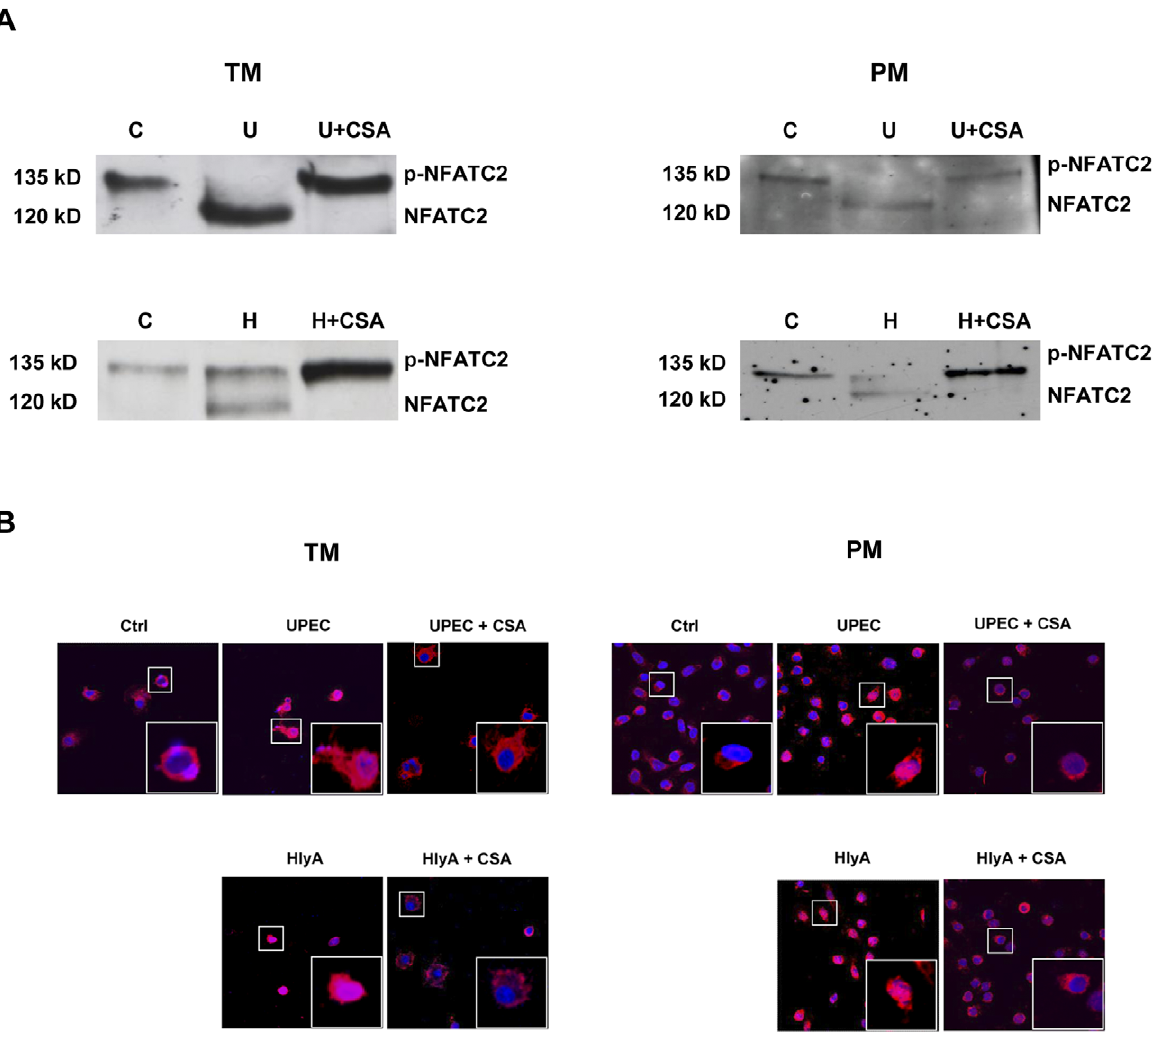
Figure 5. UPEC activates NFATC2 signaling pathway. ( A, B ) PM and TM were treated with UPEC CFT073 (MOI=20) for 1 h. ( A ) TM and PM were pretreated for 15 min with 2 m M cyclosporine A (CSA) or left unstimulated, followed by incubation with UPEC CFT073 or 40 ng/ml alpha- hemolysin (H) for 30 min, respectively. For Western blot analysis 40 m g of protein were separated on a 7.5% SDS-PAGE and immunoblots were probed using an anti-NFATC2 antibody (NFAT). ( B ) UPEC CFT073 and alpha-hemolysin (HlyA) induced calcineurin-dependent NFATC2 nuclear translocation. TM and PM were pretreated with 2 m M of the calcineurin inhibitor CSA for 15 min or left unstimulated with subsequent challenge by UPEC (MOI=20) or 40 ng/ml HlyA for 30 min. In support of the data shown in ( B ), nuclear translocation of NFATC2 (red) after UPEC CFT073 and HlyA treatment was observed in both TM and PM. Pretreatment of PM and TM with CSA blocked NFATC2 nuclear translocation. Nuclei were counterstained with Cy5-conjugated